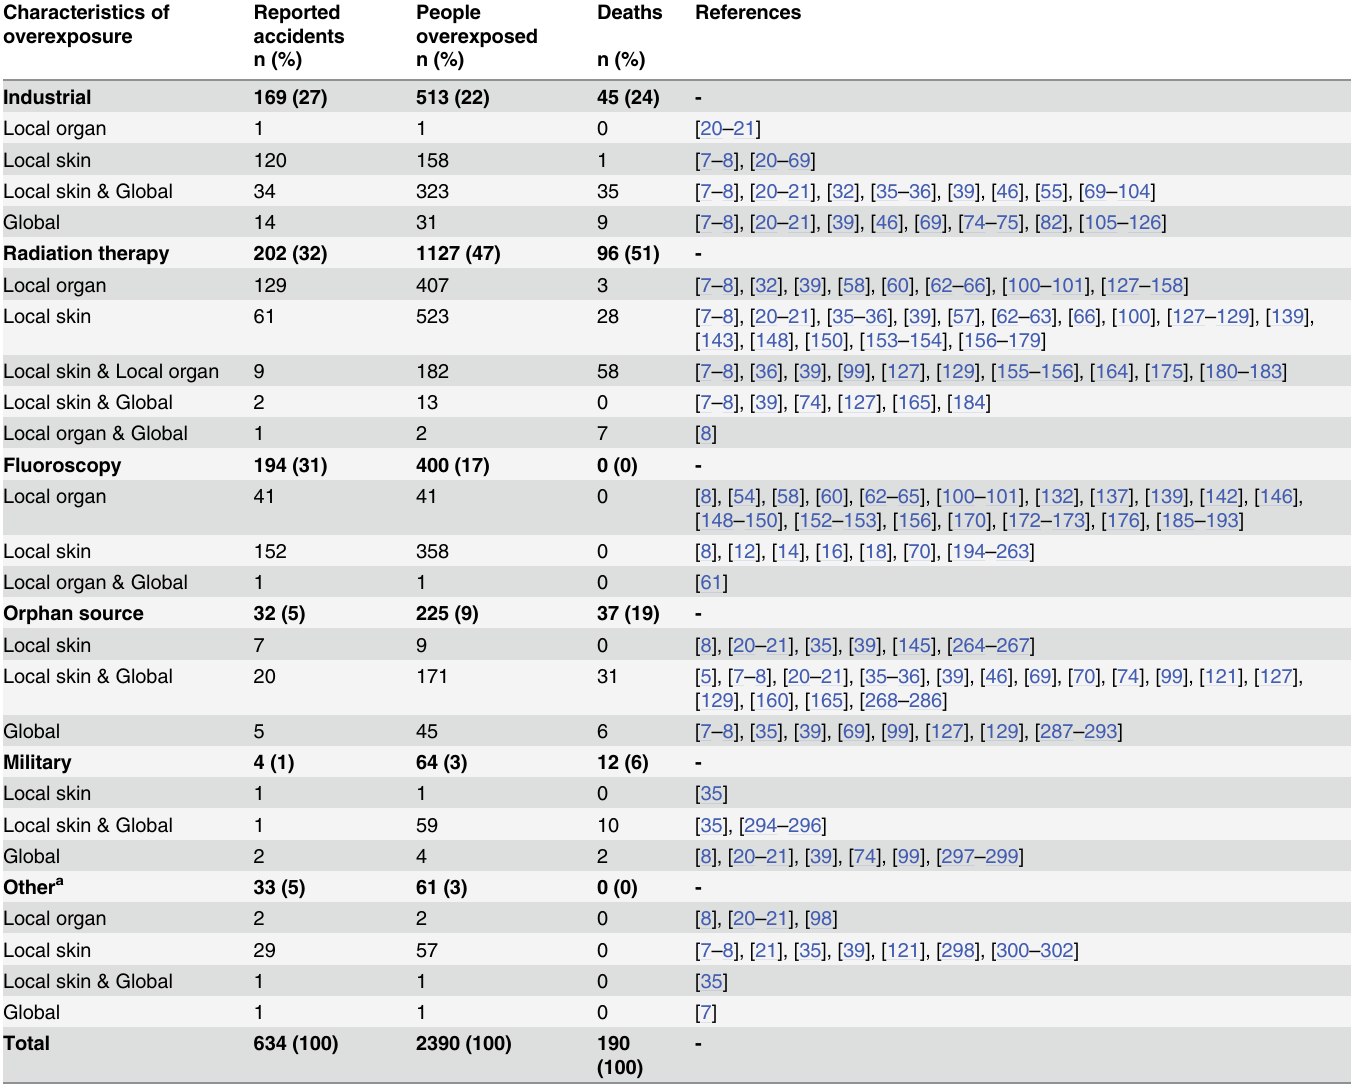
Table 1. Reported radiation overexposure accidents by sector and type of overexposure worldwide, 1980 – 2013. Characteristics of